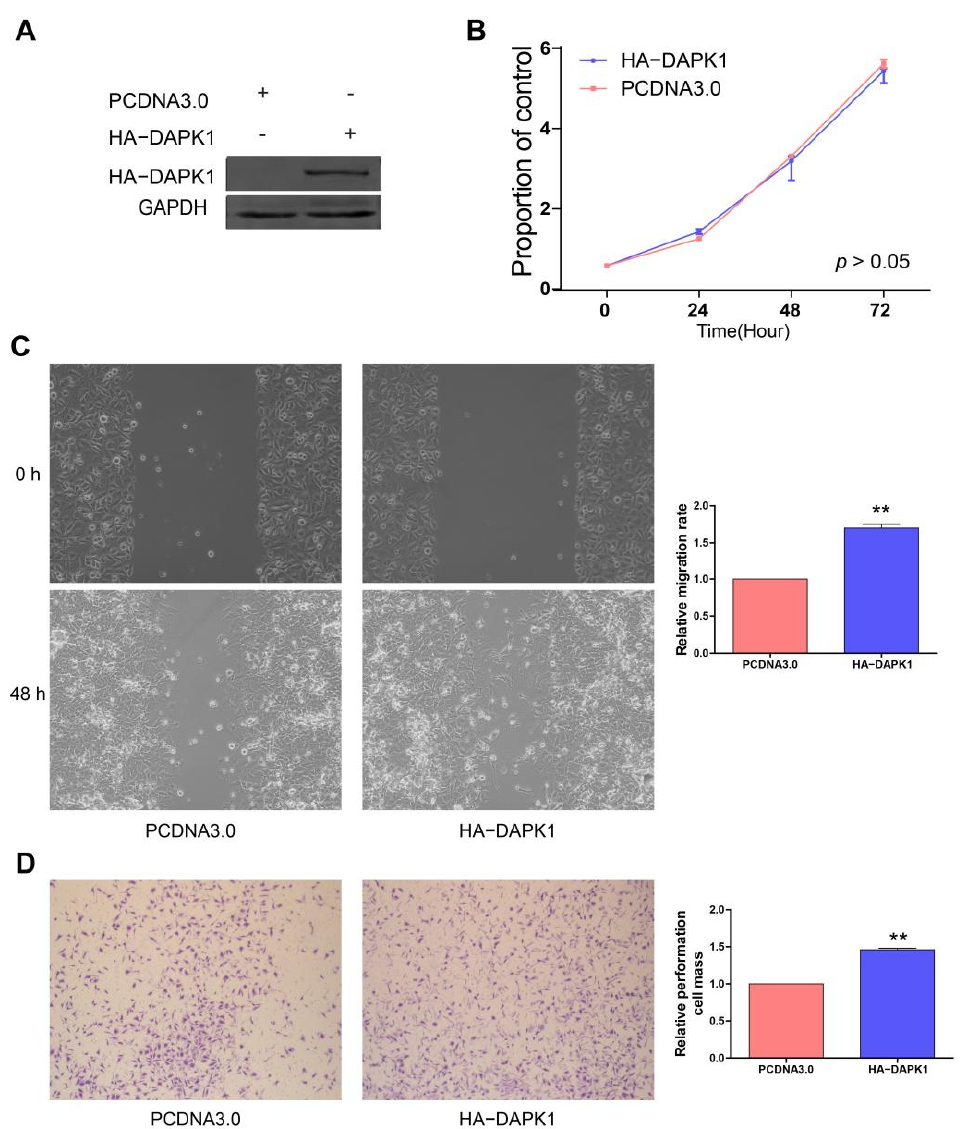
Figure 5. Overexpression of DAPK1 promotes GC cell migration and invasion. ( A ) Western blot was used to detect the levels of DAPK1 in MGC-803 cells transduced by HA-DAPK1; ( B ) DAPK1 did not significantly affect MGC-803 cell proliferation by using CCK8; ( C ) DAPK1 promoted MGC-803 cell migration; ( D ) DAPK1 promoted MGC-803 cell invasion. ** p < 0.01. Please find the original western blot of ( A ) in the Figure S2.